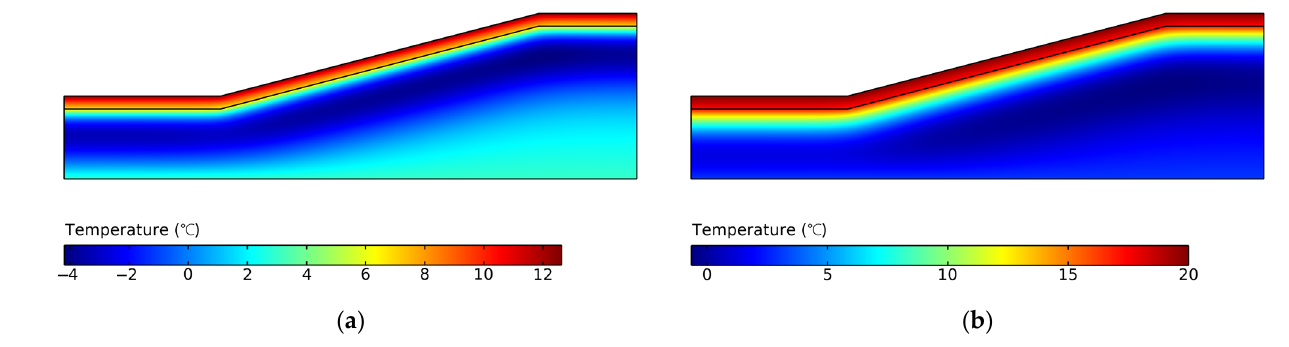
Figure 6. Temperature distributions of the canal at ( a ) 110 h and ( b ) 146 h.